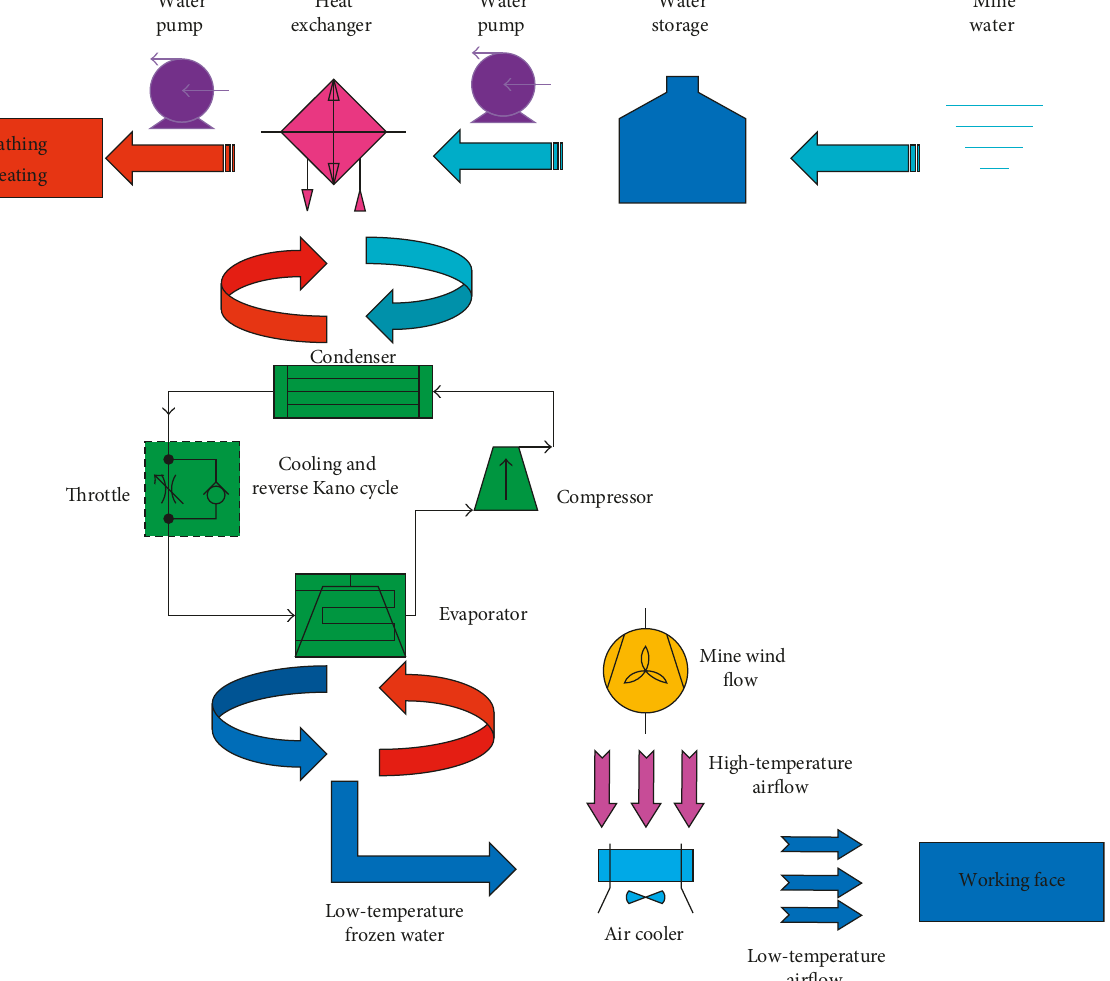
Figure 2: Cooling system of mine water as cold